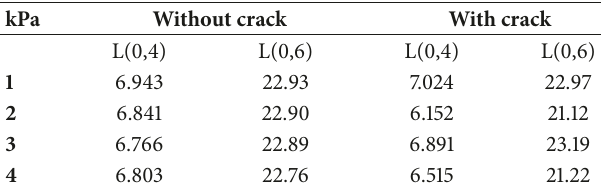
Table 3: Amplitudes of L(0,4) and L(0,6) without and with crack when the rotor is at